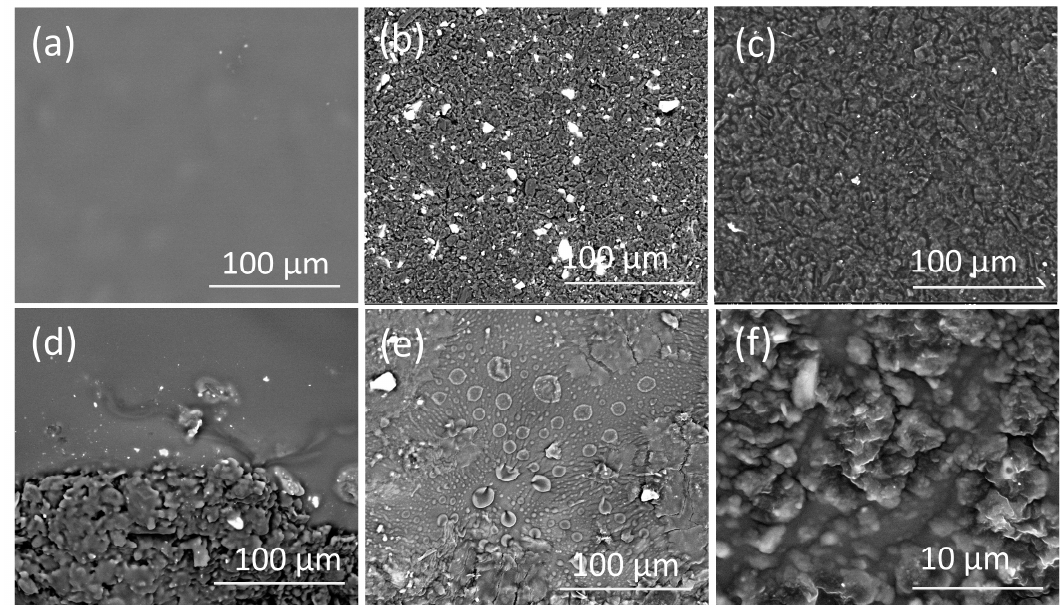
Figure 6. SEM image of the prepared electrodes: ( a ) PVC membrane of sensor 3 (PVCEs), ( b ) carbon paste of sensor 7 (CPE, 47%Gr), ( c ) carbon paste of Sensor 11 (CPE, 44%Gr + 3%GO), ( d ) PVC membrane coated on carbon paste electrode of sensor 13 (C-CPE), ( e , f ) PVC plasticized carbon paste electrode of sensor 16 (P-CPE). The electrode compositions (%, wt / wt ) are given in Table 1.